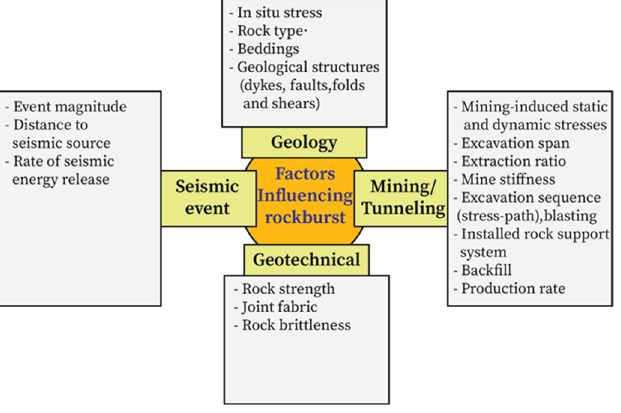
Figure 8. The main factors influencing rockburst damage and its severity (modified after ref. [2]).